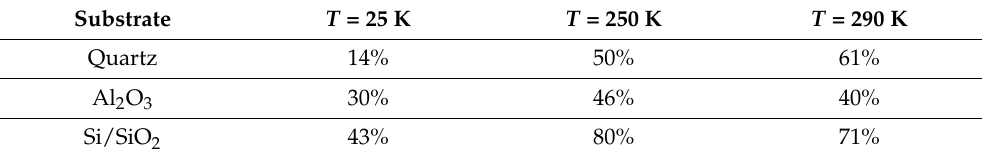
Table 2. Magnetoresistance anisotropy ( MRA ) of the 360 nm-thick films grown on different substrates, measured at ambient temperatures T = 25 K, 250 K, and 290 K at magnetic flux density of 0.7 T.